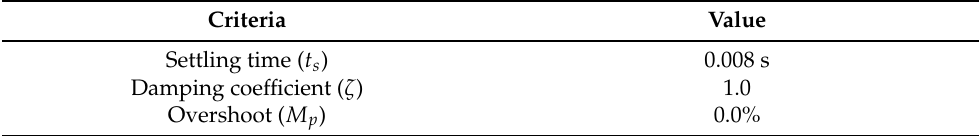
Table 4. Performance criteria for the current loops controllers ( i d and i q